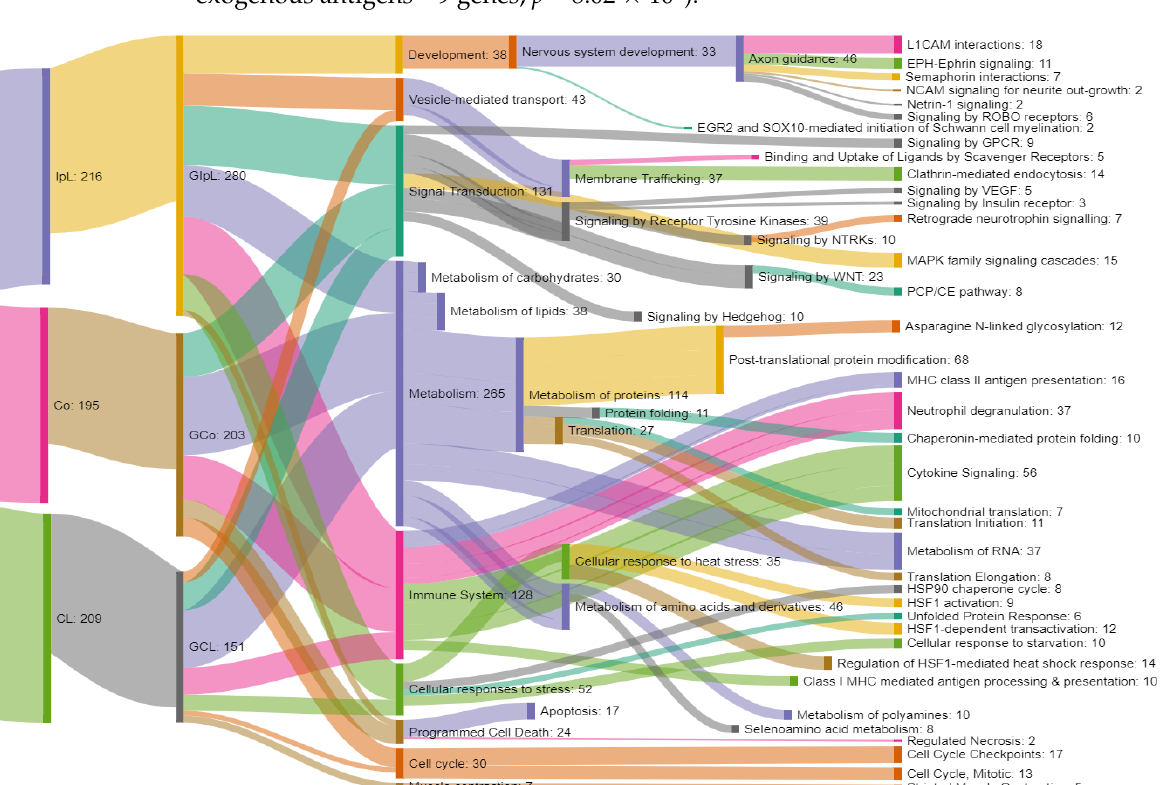
Figure 4. The PANTHER classification of the identified proteins in the brain by molecular function ( A ), biological processes ( B ), and class of proteins ( C ).